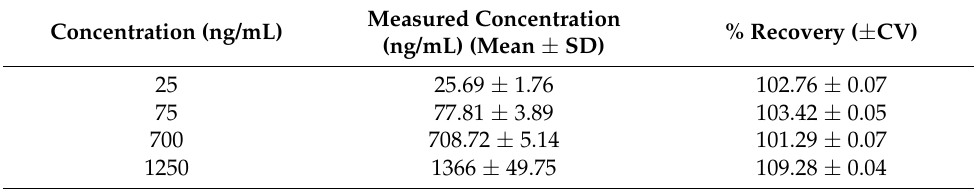
Table 3. Recovery data for glipizide in spiked plasma ( n =